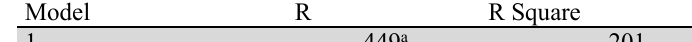
The summary of statistical tests for the regression